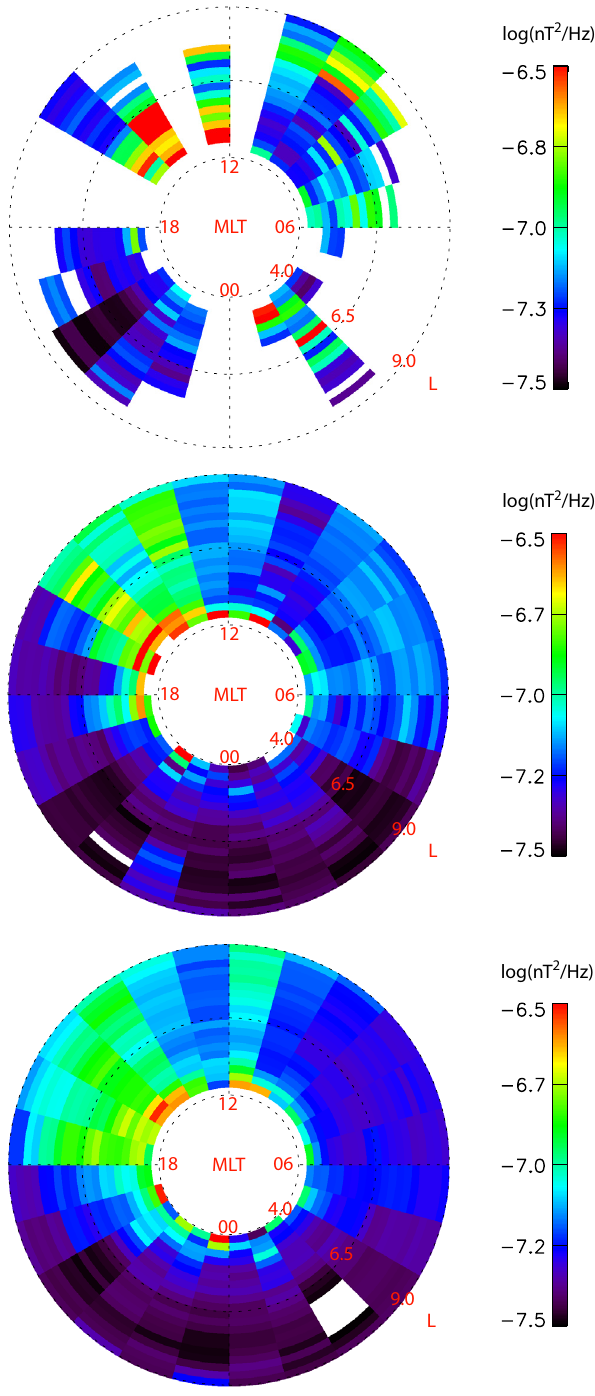
Fig. 5. Distributions of the spectral density in the frequency range 0 . 0005 ≤ f/f ce < 0 . 02 (magnetosonic waves) for different K p lev- els. Top, central, and bottom panel corresponds, respectively, to high ( K p ≥ 5o), moderate (3o ≤ K p < 5o), and low ( K p < 3o) levels of magnetospheric